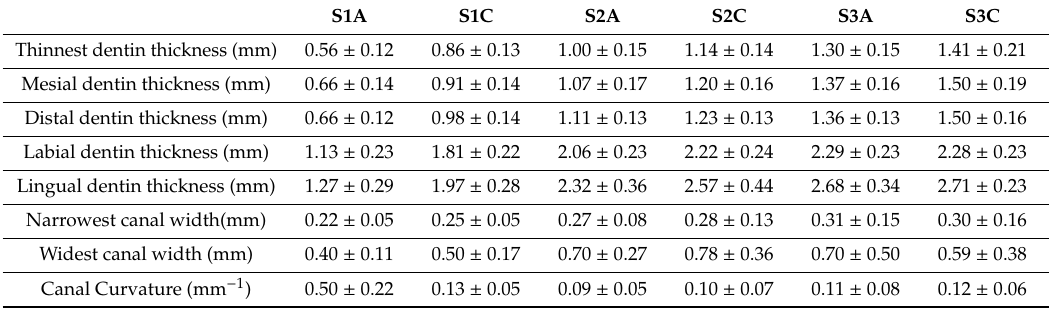
Figure 5. Measurements of dentin thicknesses. The average dentin thickness was measured on the mesial, distal, labial, and lingual sides, and the thinnest dentin thickness (MinDist), narrowest canal width (Canal width (min)), and the widest canal width (Canal width (max)) were plotted along the entire length of the canals. Table 1. Mean values of dentin thicknesses, canal widths, and canal curvatures.